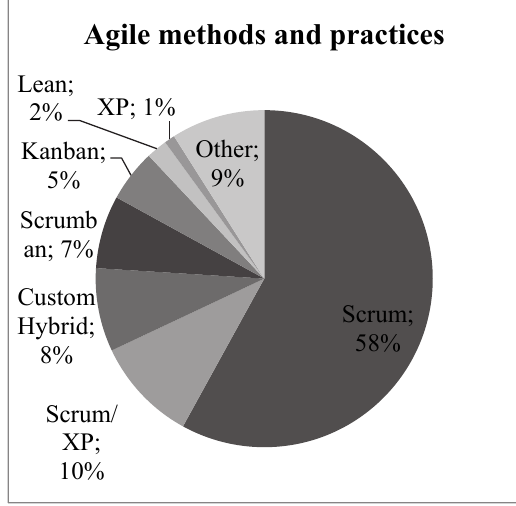
Fig. 1. The popularity of agile methodologies and